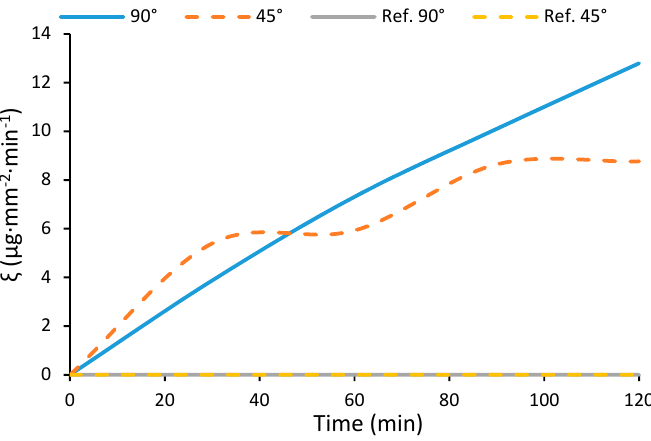
Figure 14. The water collection rate increase in both sample positions, vertically (90 ◦ ) and tilted Figure 14 . The water collection rate increase in both sample positions, vertically (90°) and tilted (45°) (45 ◦ ) (solid and dotted line, respectively), but it is more pronounced at 90 ◦ . References of aluminum (solid and dotted line, respectively), but it is more pronounced at 90°. References of aluminum substrates (Ref 90 ◦ and Ref 45 ◦ ) are not capable of water collection and are overlapped with substrates (Ref 90° and Ref 45°) are not capable of water collection and are overlapped with x-axis.